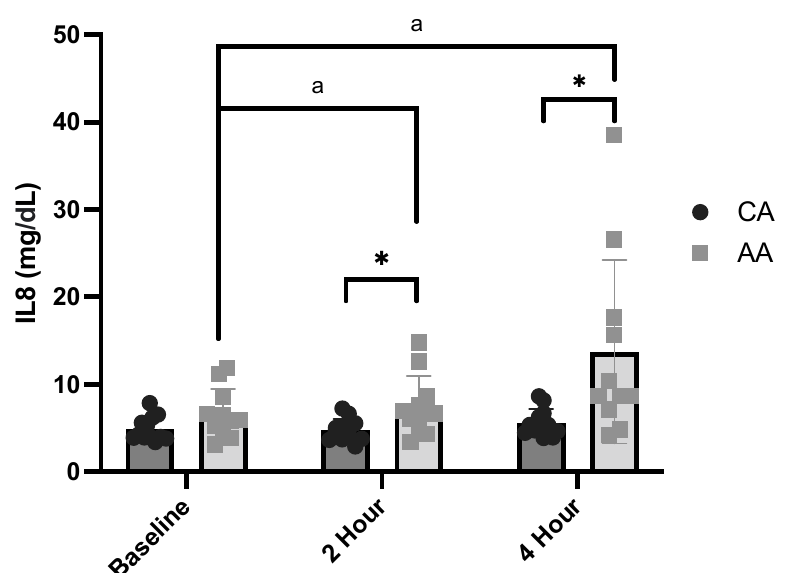
Figure 3. Baseline and postprandial IL-8 response to a high-fat meal in African American and Cau- casian American females (ANOVA: Time, p = 0.039, η p2 = 0.277; Group, p = 0.050, η p2 = 0.259; n = 23). p ≤ 0.05 between CA vs. AA females. p ≤ 0.05 between AA and CA, a p ≤ 0.05 compared to baseline for AA females. AA—African American; CA—Caucasian American.